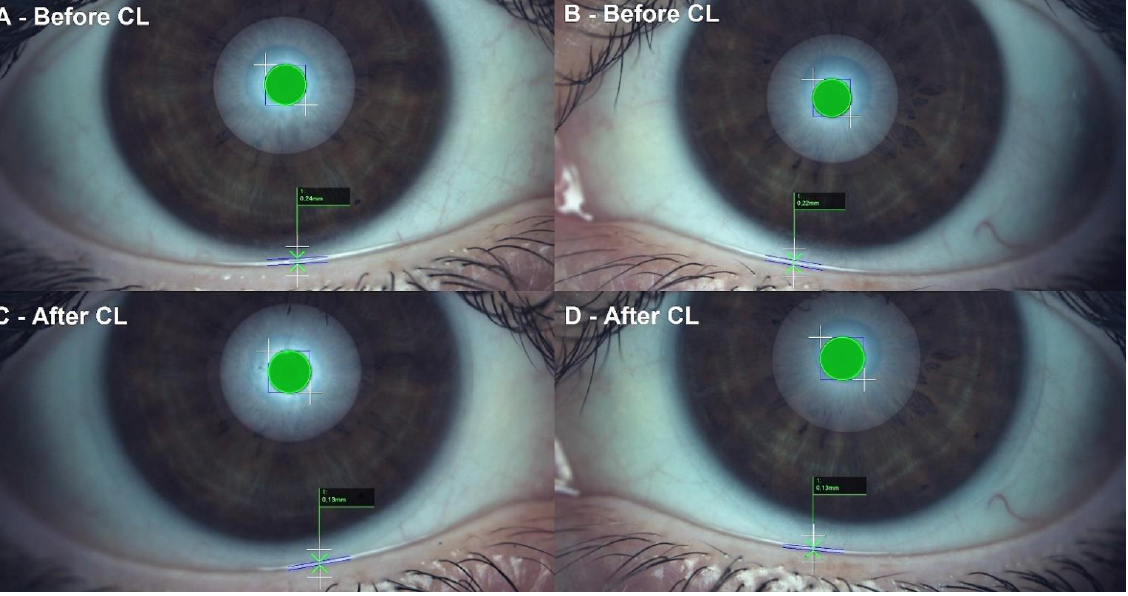
Figure 2. Tear meniscus height decreased from baseline to one-month follow-up. ( A ): Right eye baseline, 0.24 mm, ( B ): Left eye baseline, 0.22 mm, ( C ): Right eye after one month, 0.13 mm and ( D ): Left eye one month, 0.13 mm. This figure was a singular participant example (subject 5, both eyes).